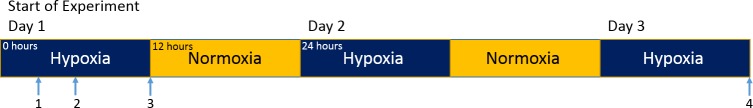
Sampling scheme displaying collections over treatment period (blue signifying overnight bubbling and yellow, the return to normal oxygen levels during the day).Arrow 1 corresponds to the ‘3 h’ collection time point, 2 to ‘6 h,’ 3 to ‘1 day,’ and 4 to ‘3 days.’ ‘Day 5’ of bubbling was omitted, as tissue loss rendered those samples unsuitable for analysis.